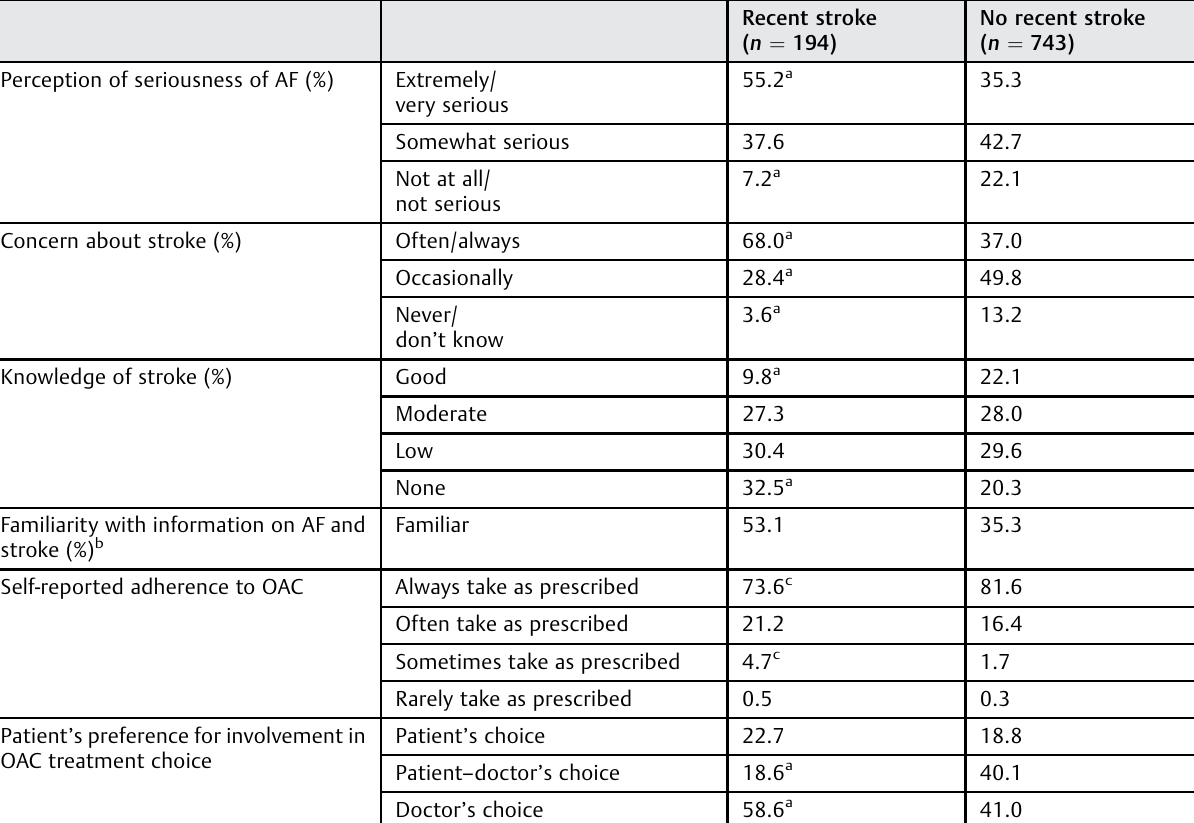
Table 3 Patients ’ perceptions about AF and stroke, level of stroke knowledge, self-reported adherence to OAC, and preference for involvement in OAC treatment choice overall and by recent stroke/no recent stroke